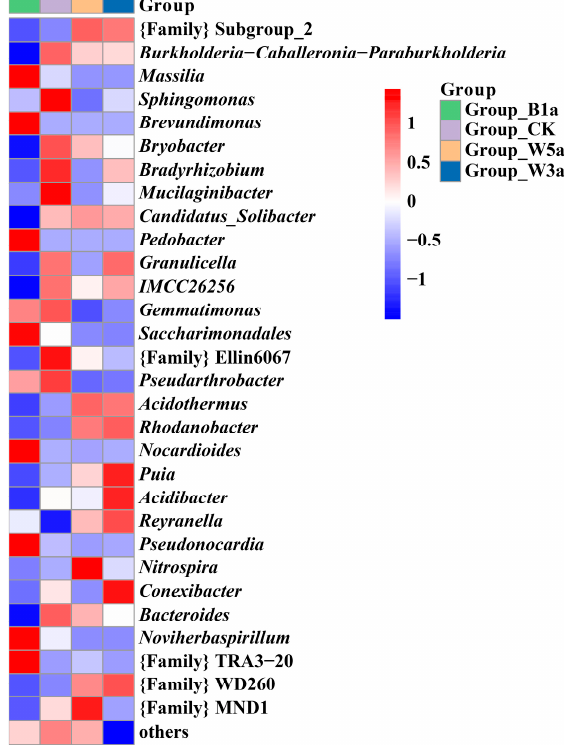
Figure 2. The composition of bacterial communities at the genus level in the casing soil of different treatments of G. leucocontextum cultivation.